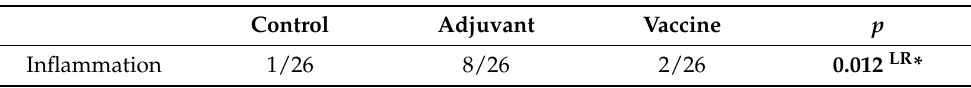
Table 4. Inflammation (i.e., interstitial and/or periductal aggregates of lymphocytes, plasma cells, and/or histiocytes) in the pancreas in Control, Adjuvant-only (Adjuvant), and Vaccine groups ( n = 26 each) of all flocks grouped together. Data provided as animals with the histological lesion relative to the total number of animals analyzed. Methodology of histopathological evaluation detailed in Tables A3–A11 (Appendix